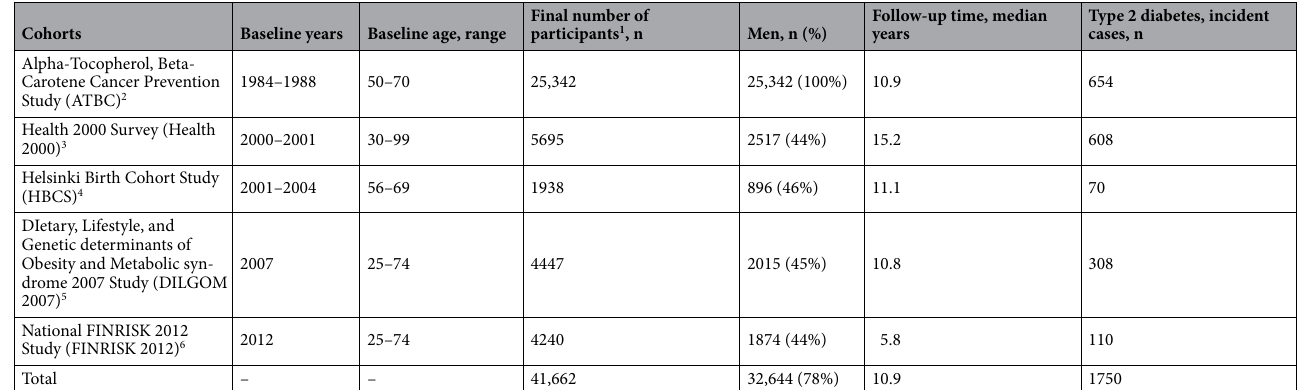
Table 1. Cohorts included in the pooled analyses of partial substitution red or processed meat with plant- based foods and type 2 diabetes risk. 1 Including participants with an acceptable food frequency questionnaire (FFQ) and without prevalent type 2 diabetes at baseline. 2 The ATBC Cancer Prevention Study Group 1994 13 . 3 Heistaro 2008 14 . 4 Eriksson 2011 15 . 5 Konttinen et al. 2010 16 . 6 Borodulin et al. 2018 17